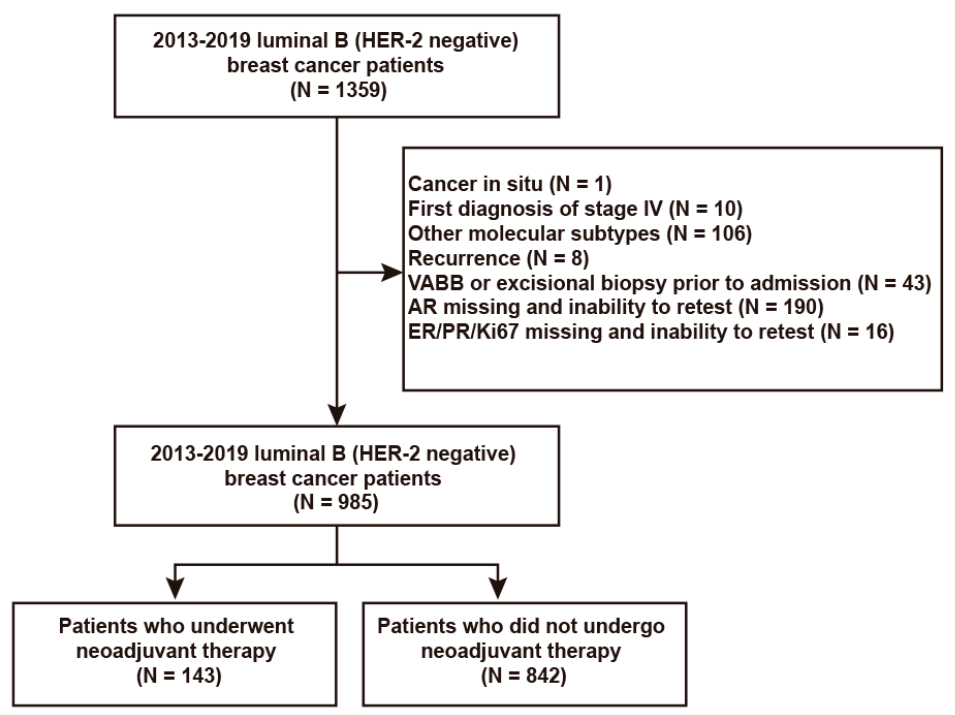
Figure 1. Flowchart of inclusion of luminal B (HER–2 negative) breast cancer patients.